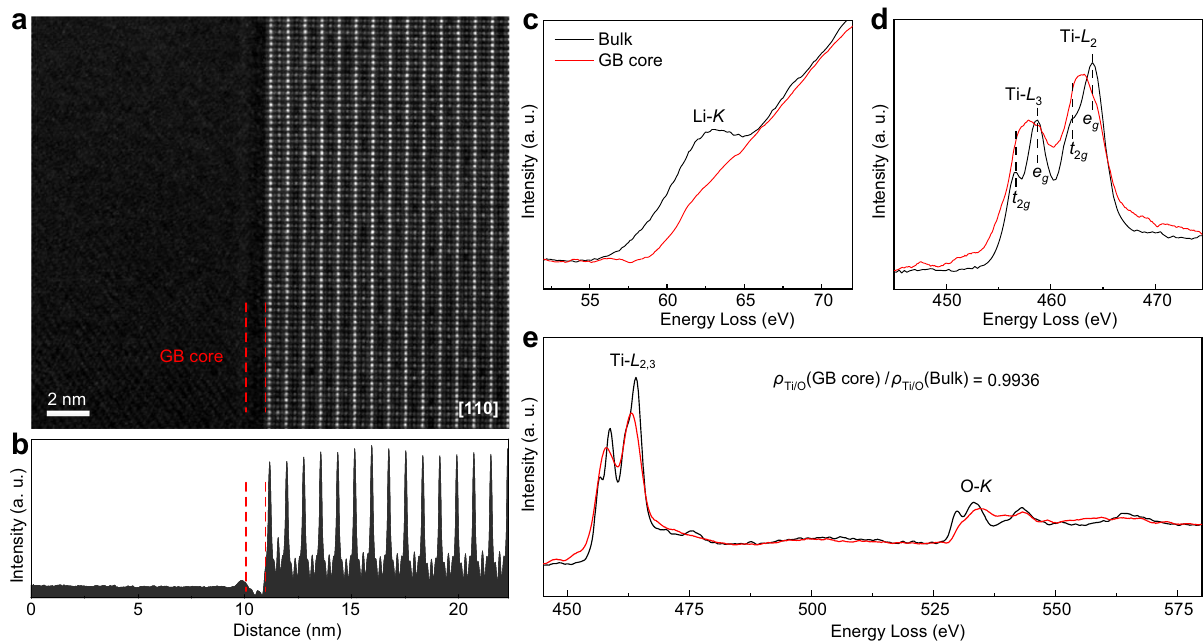
Fig. 1 | Probing the charge ofthe grain-boundary core.a , b HAADF-STEMimage ( a ) and the corresponding accumulated intensity pro fi le ( b ) of a grain-boundary (GB) core. The region indicated with red dashed lines is the grain-boundary core with darker contrast. c – e EELS data of Li- K ( c ), Ti- L 2,3 ( d ), and O- K edges ( e ). To